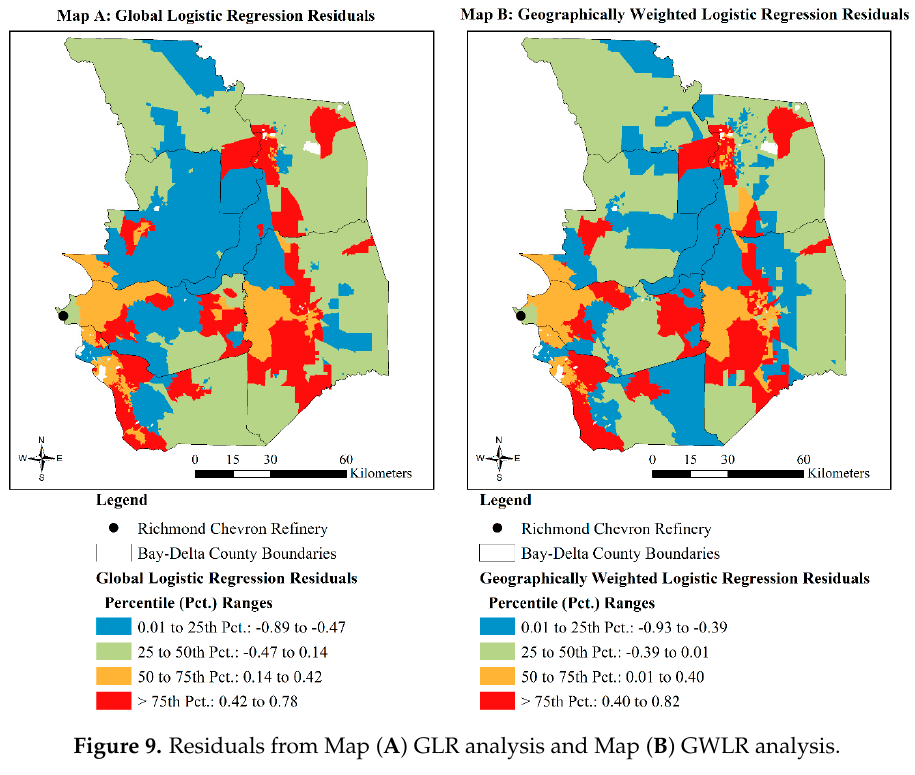
Figure 8. GWLR model fit statistic: Percent local deviance explained by block group.